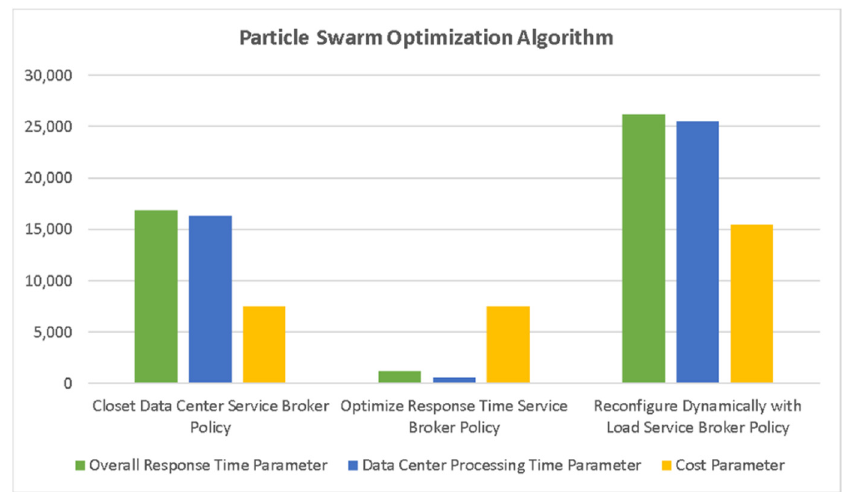
Figure 11. The analysis of the performance parameters of PSO based on 3 service broker policies.